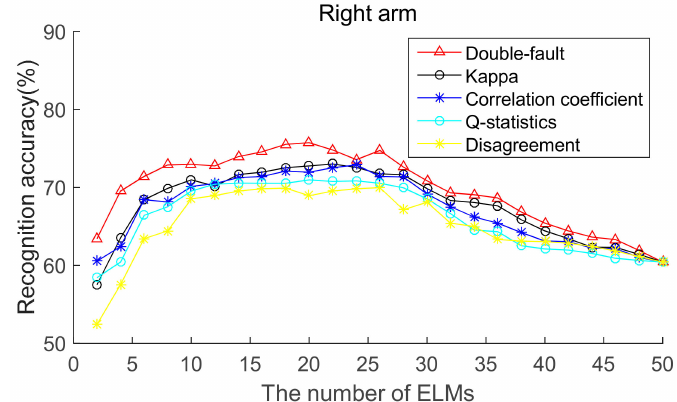
Figure 8. Recognition accuracy from right arm position for ordered bagging according to five pairwise diversity